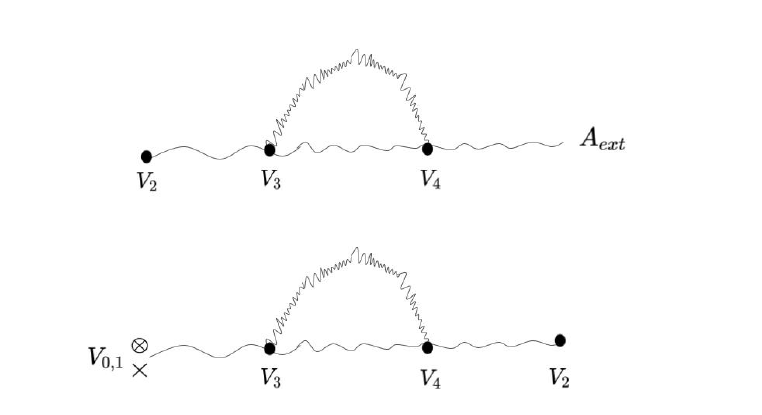
) and the ext , P that 02 12